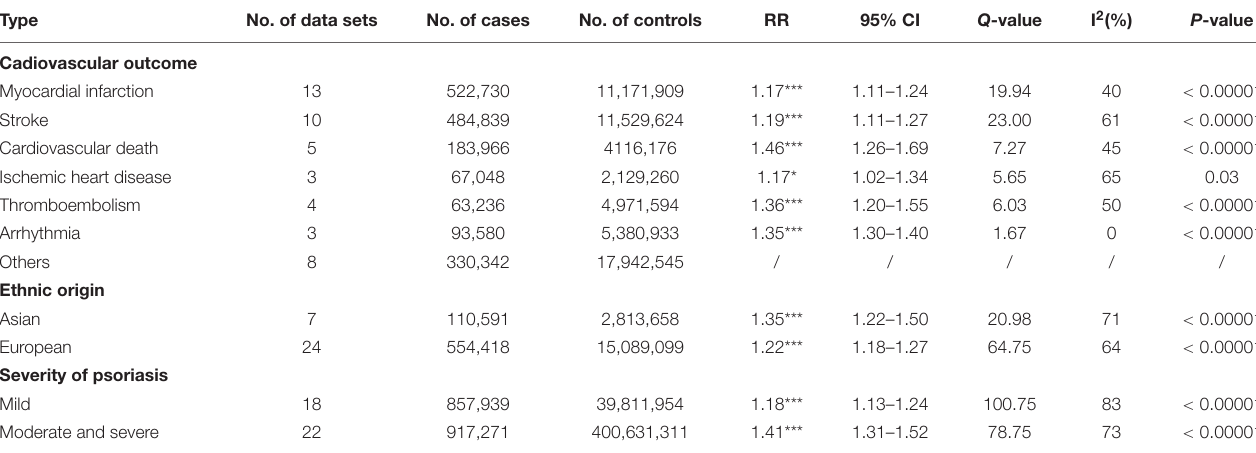
TABLE 3 | Estimates of RRs and the 95% CIs for adverse cardiovascular disease and heterogeneity test for studies with Cochran’s Q -test and the quantity I 2 .